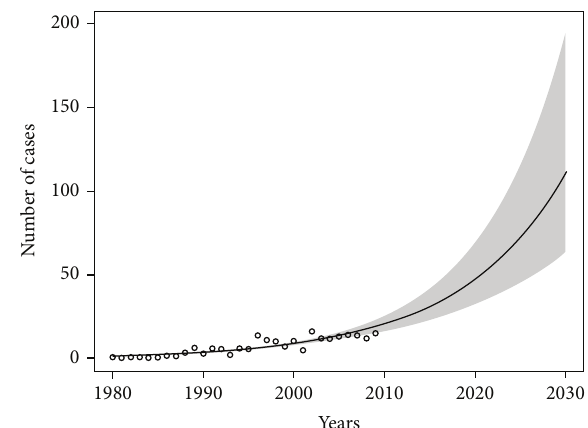
Figure 3: The forecast of increasing incidence of asbestos-related lung cancer in the zone number II until 2030. Significance level of model: 𝑃 < 0.01 .